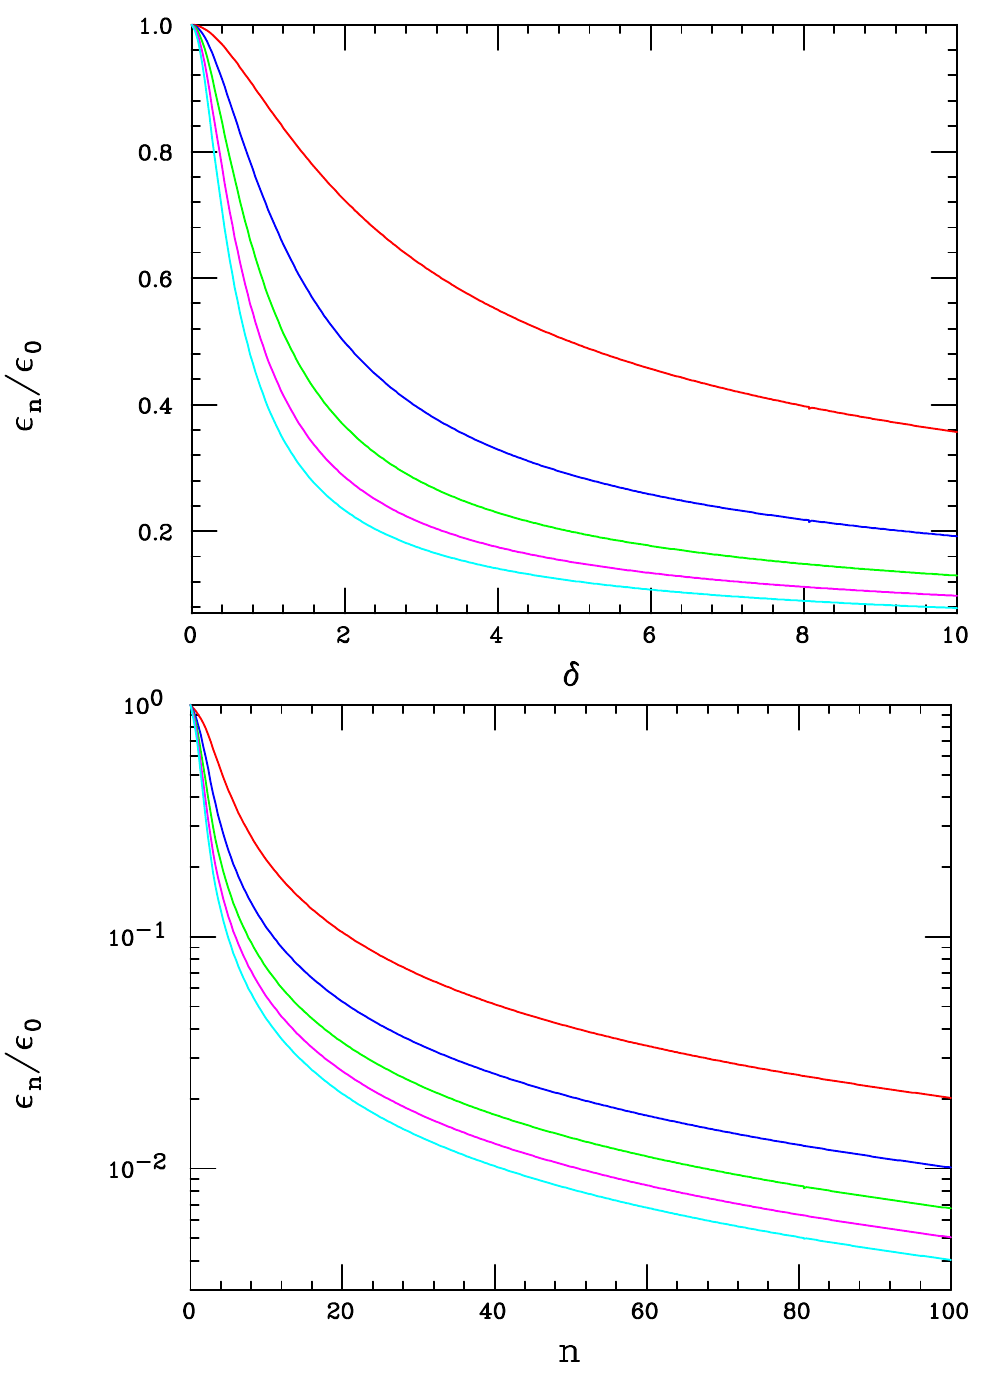
Figure 1 . Top: (cid:15) n =(cid:15) n =0 as a function of (cid:14) A for, from top to bottom, n = 1 ; 2 ; : : : 5. Bottom: the same ratio but now as a function of n ; from top to bottom the curves are for (cid:14) A = 1 ; 2 ; : : : 5.